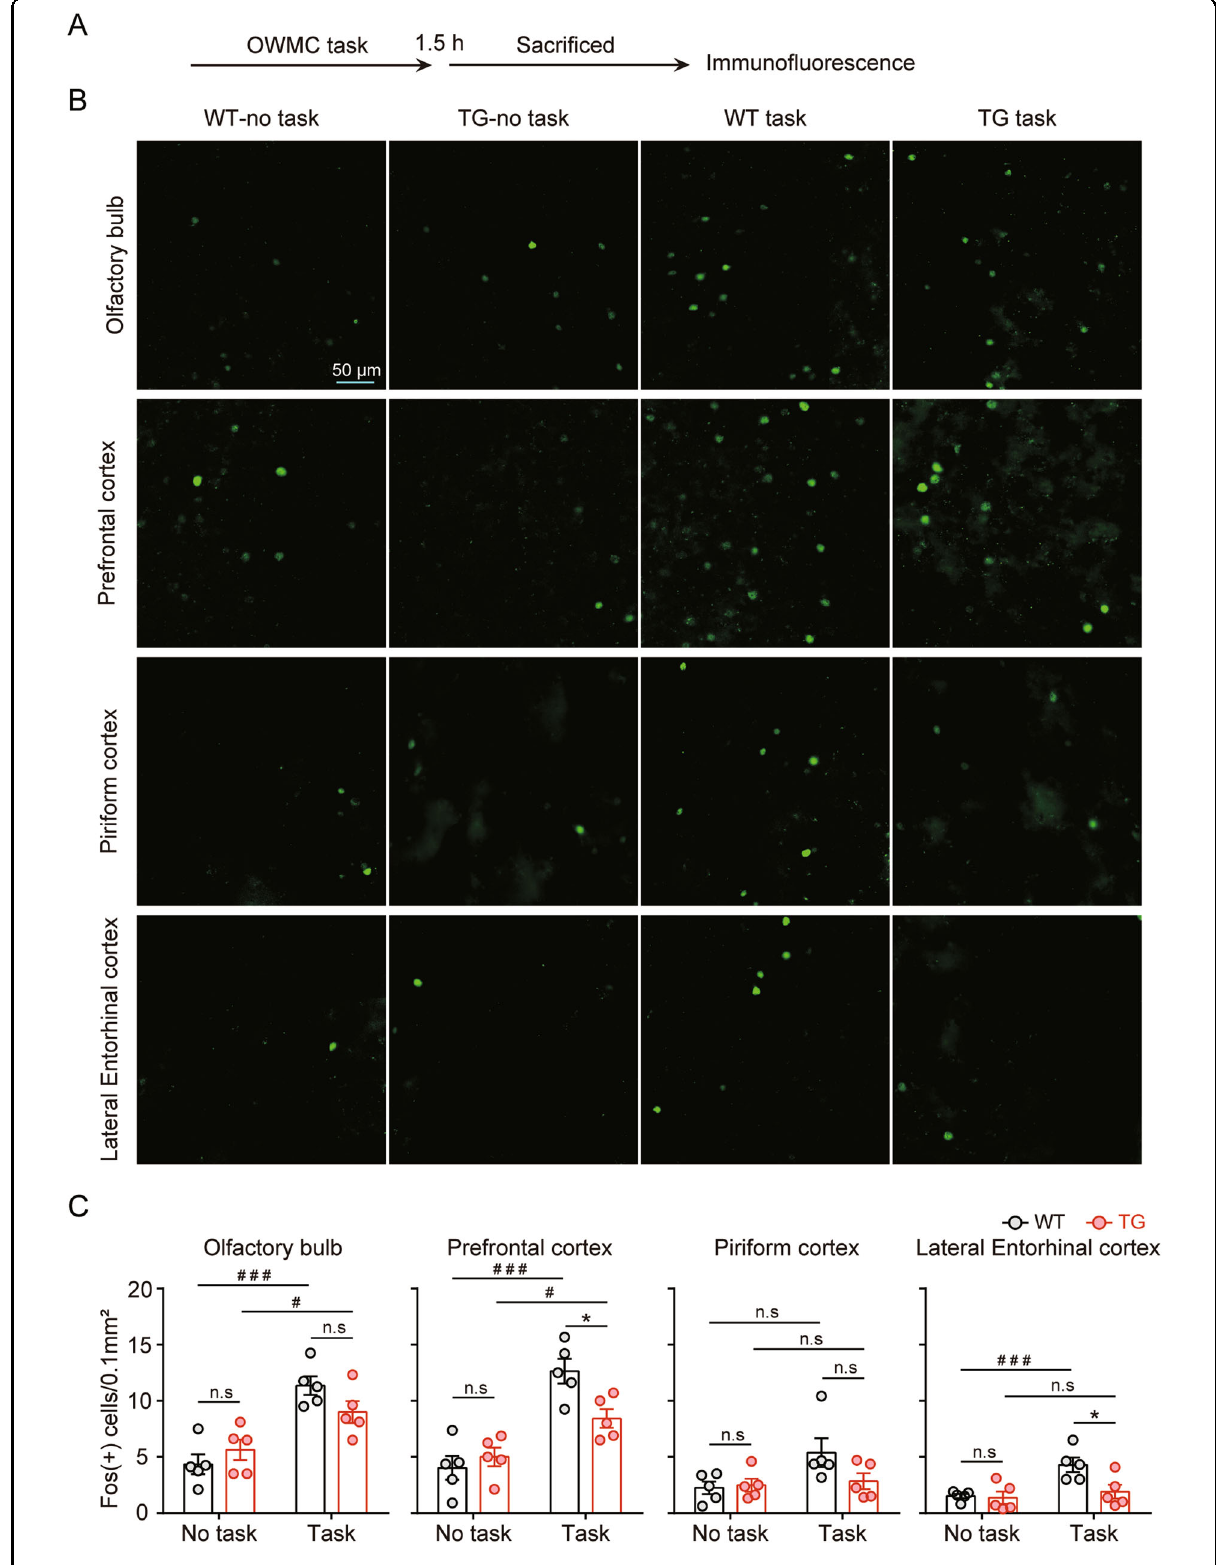
Fig. 4 (See legend on next